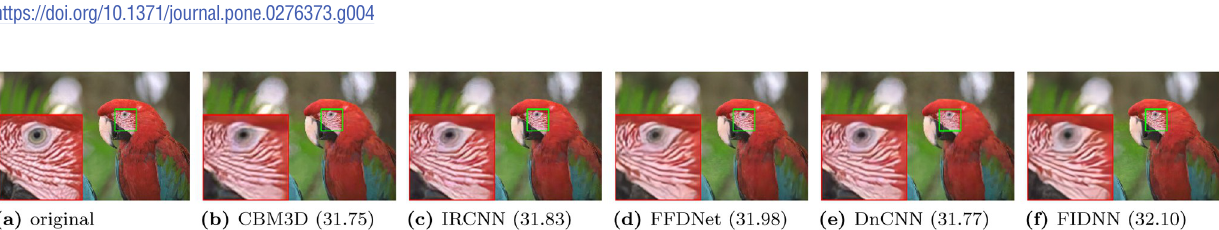
Fig 5. Color image denoising results for noise level 50 on ‘Kodim23’ image from Kodak24 dataset. (a) original. (b) CBM3D (31.75). (c) IRCNN (31.83). (d) FFDNet (31.98). (e) DnCNN (31.77). (f) FIDNN (32.10).